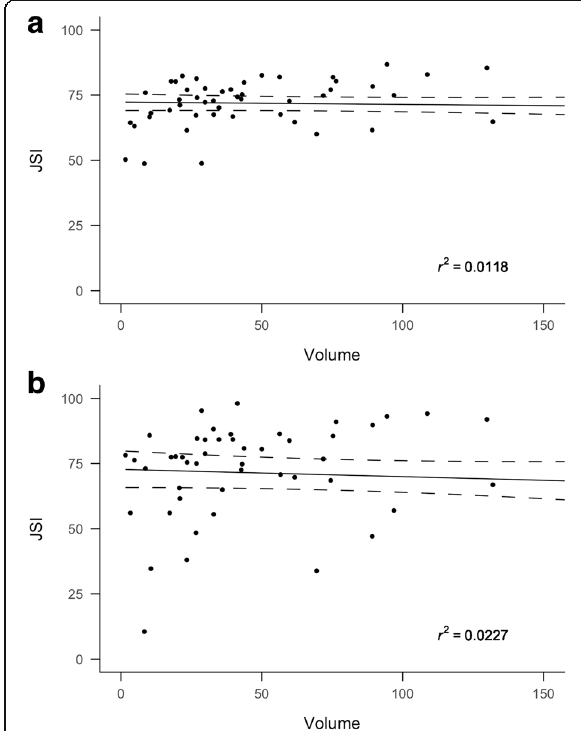
Fig. 2 Lesion volumes computed with FLAB are plotted against JSI between FLAB and FH ( a ) and JSI between FLAB and 40P ( b ). Slope lines are shown along with 95% standard error of slope ( dashed lines ). r 2 values are displayed on the figures. The nearly straight slope lines and small r 2 imply that there is no particular trend to the degree of mismatch between FH and FLAB derived volumes over the range of tumour sizes. JSI Jaccard similarity index